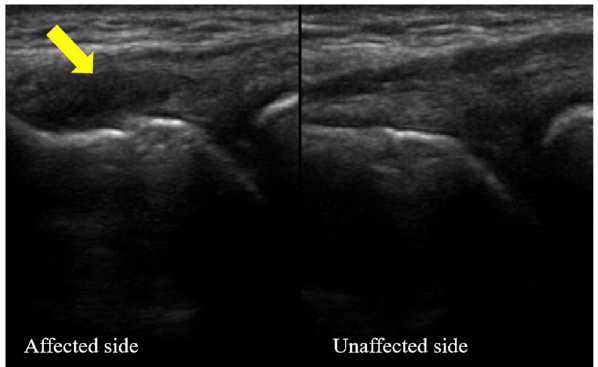
Figure 1. The ultrasound images of the lateral side of the left elbow affected with refractory lateral epicondylitis (case one) at the baseline. Bilateral comparison of the common extensor tendons: left elbow (affected side) and right elbow (unaffected side). The arrow points to the diseased tendon.